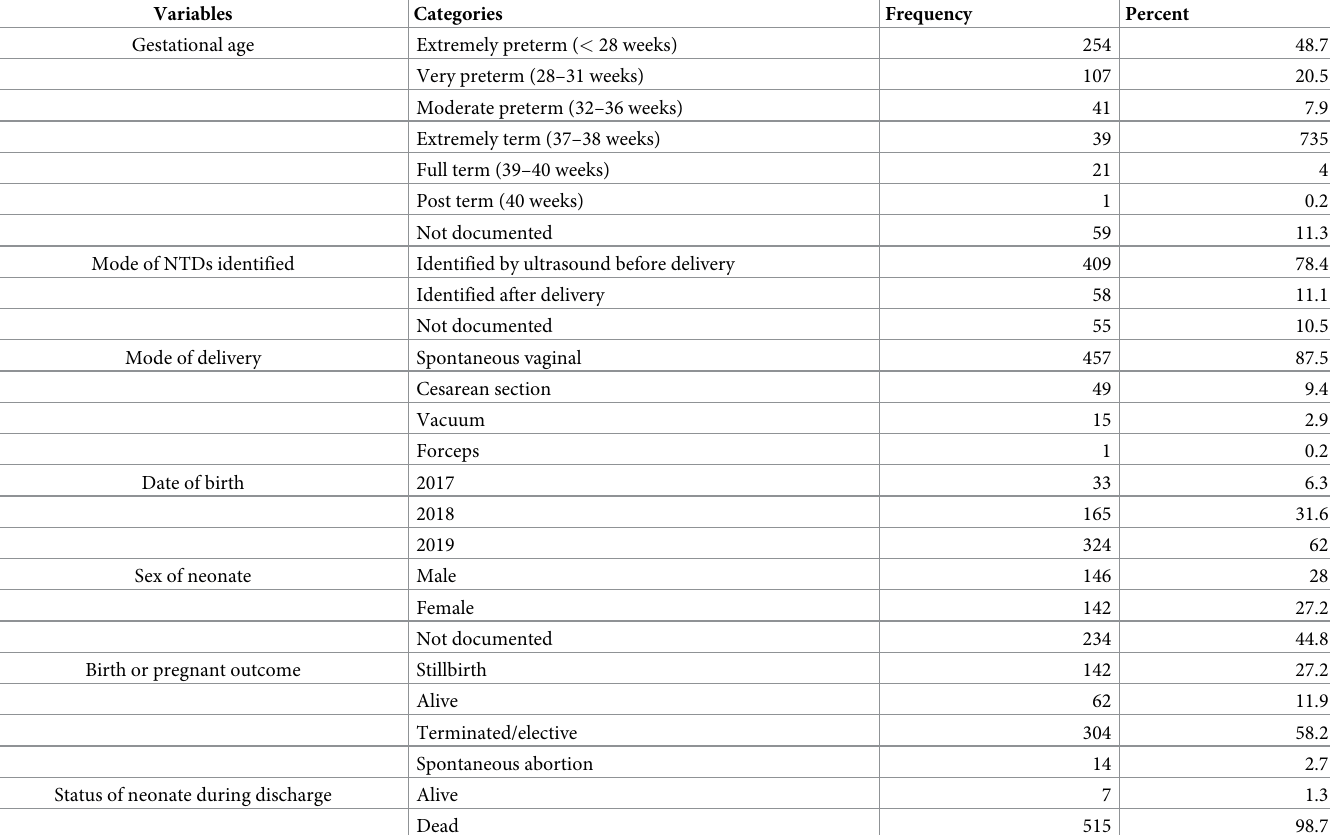
Table 4. Obstetric history of pregnant women, Eastern Ethiopia, data from 2017–19.